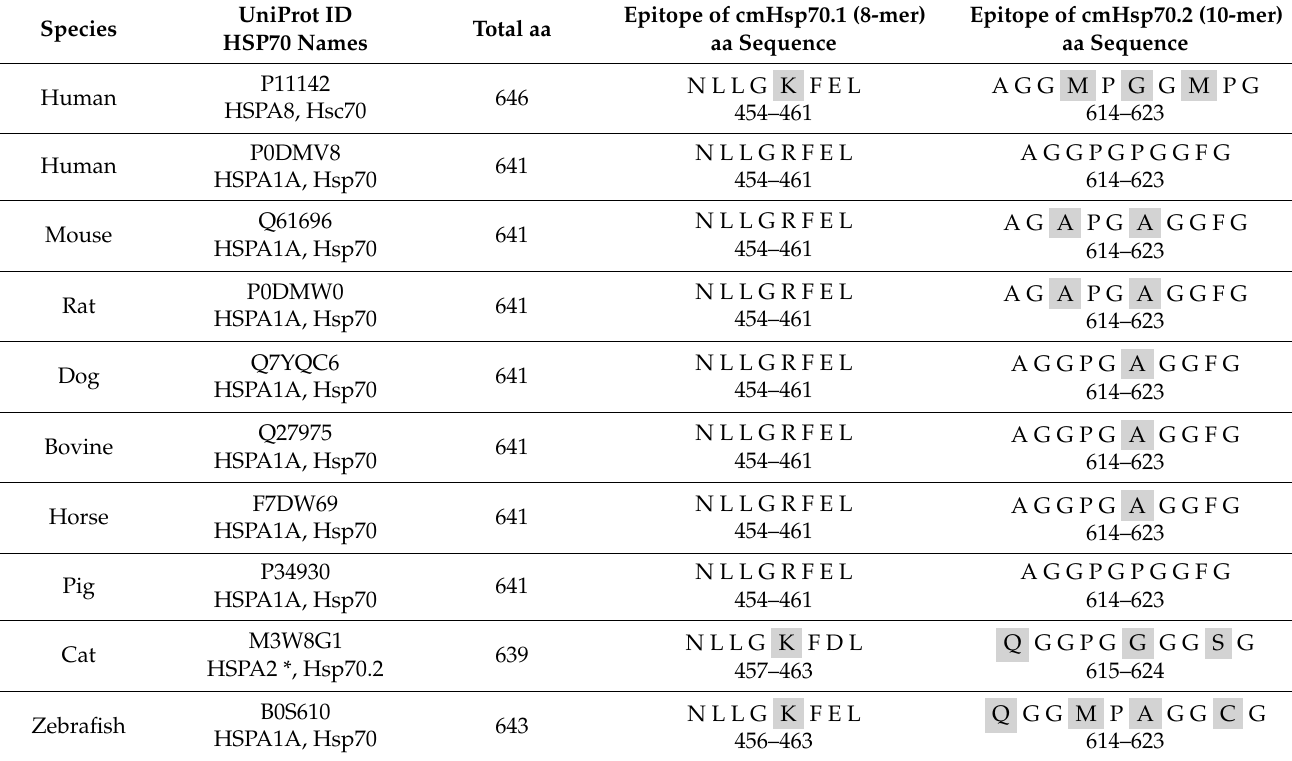
Table 1. Comparison of Hsc70 (HSPA8) and Hsp70 (HSPA1A) and inter-species comparison of the 8-mer (aa 454–461) and 10-mer (aa 614–623) sequences of Hsp70 (HSPA1A) in humans and different other species based on the UniProt database. The given HSP70 sequences contain the epitopes of the cmHsp70.1 and cmHsp70.2 mAbs. (*) For feline Hsp70, only the aa sequence of HSPA2 is available. Amino acid (aa) exchanges are marked in